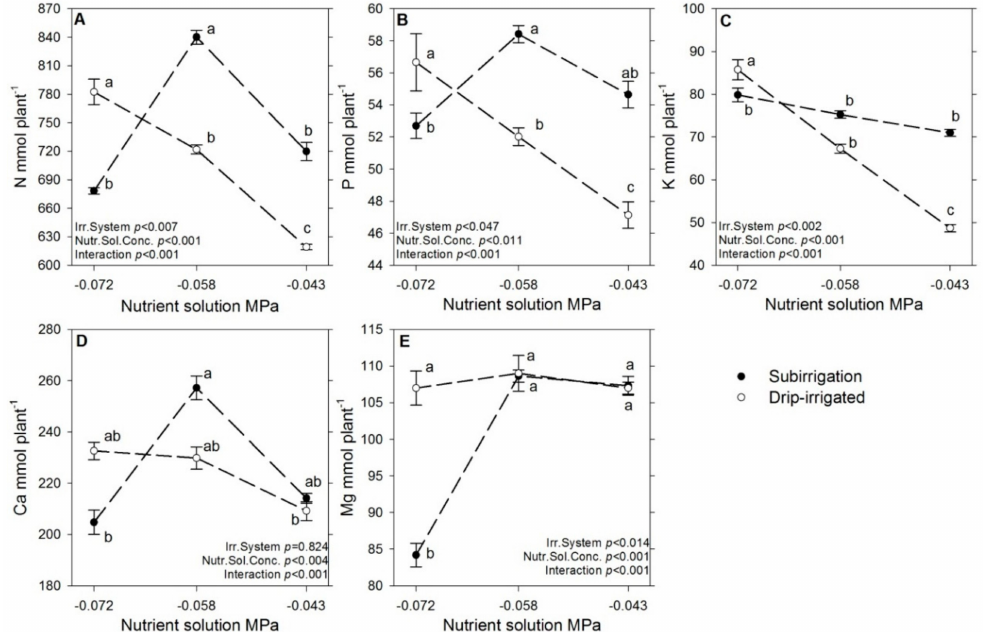
Figure 3. ( A – E ) E ff ect of the irrigation system and the concentration of the nutrient solution on total tomato ( Solanum lycopersicum L.) plants content of nitrogen (N), phosphorus (P), potassium (K), calcium (Ca), and magnesium (Mg). ANOVA significance for both factors, irrigation system (Irr. System) and nutrient solution concentration (Nutr. Sol. Conc.), and the interaction is shown. Means with the same lower-case letter indicate non-significant di ff erences according to Tukey’s multiple comparison test. Bars represent the standard error of the mean ( n =